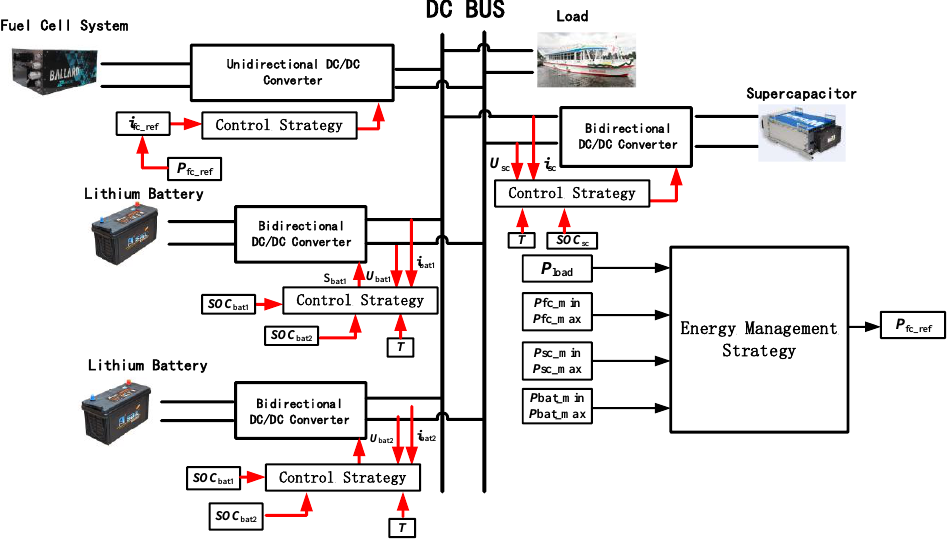
Figure 1. Block diagram of the structure of the vessel hybrid power system.